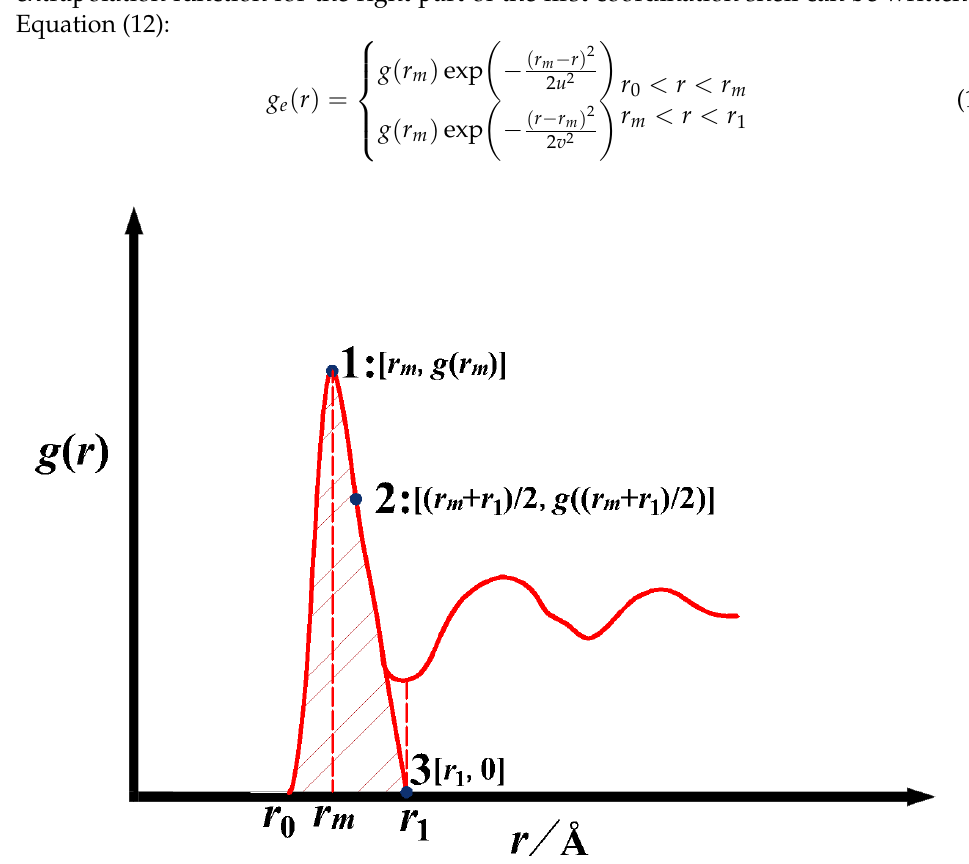
Figure 6. Schematic graph of g e ( r ) constructed by Gaussian method, 1 is ( r m , g ( r m )), 3 is ( r 1 , 0), and 2 is (( r m + r 1 )/2, g(( r m + r 1 )/2)). In Equation (12), there are two parameters, u and v , to be determined. Fitting g ( r ) in the range of r 0 − r m obtains u ; the solution of the unknown parameter v requires 3 coordinates of g ( r ): coordinate 1 (per Figure 6) is ( r m , g ( r m )), coordinate 3 is ( r 1 , 0), and coordinate 2 is (( r m + r 1 )/2, g(( r m + r 1 )/2)). The coordinates 1 and 3 are used to determine